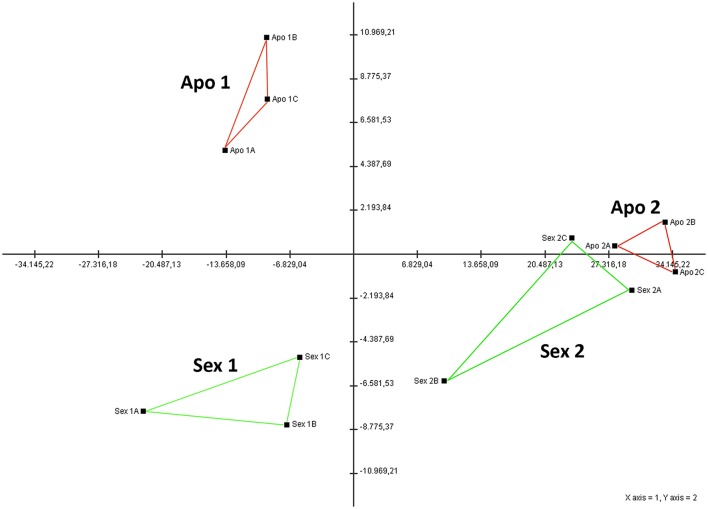
Principal component analysis (PCA) of reproduction-related DEGs gene expression in sexual and aposporous pistils. Sex1A-C, sexual samples at flower developmental stage 11; Sex2A-C, sexual samples at flower developmental stage 14. Apo1-C, apomictic samples at flower developmental stage 11; Apo2A-C, apomictic samples at flower developmental stage 14. Coloured lines were used to group the biological replicates. The percentage variation explained by the two axes is about 96%.